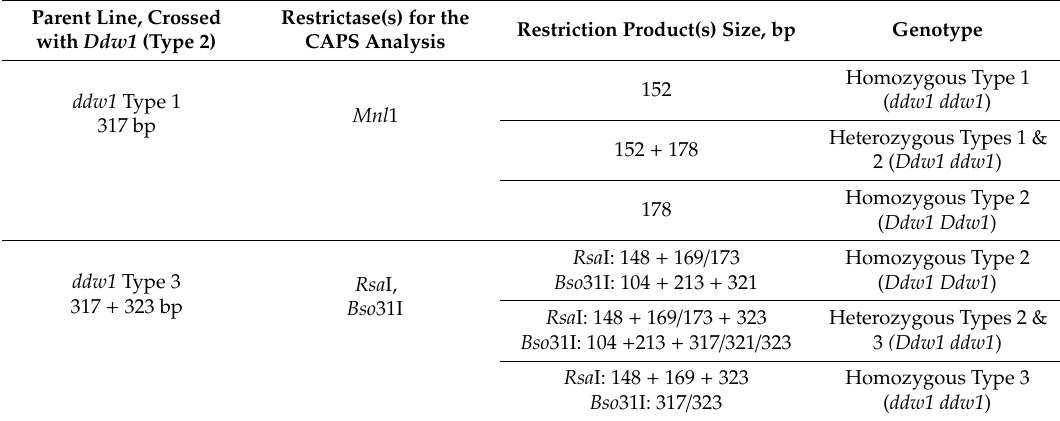
Table 3. REMS1218 CAPS analysis for Ddw1 allele(s) for MAS. In some cases, Rsa I is the only restriction enzyme required for MAS in breeding Type 3 lines (see discussion). Parent Line, Crossed Restrictase(s) for the with Ddw1 (Type 2) CAPS